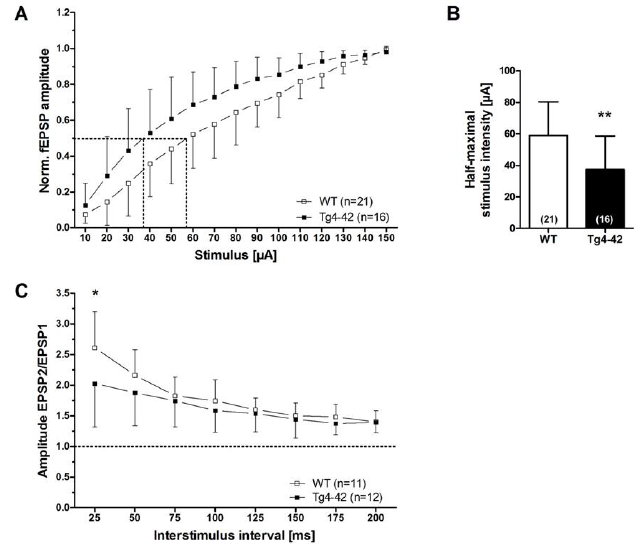
Figure 2. Aβ 4-42 induced neuronal hyperexcitability and affects short-term plasticity in 3-month-old Tg4-42 mice (taken from [16]). Impact of Aβ 4-42 on basal synaptic function and short-term plasticity in acute hippocampal tissue slices of Tg4-42 and controls at 3 months of age. ( A ) An altered basal excitatory synaptic transmission was demonstrated by a left shift of the input–output curve; ( B ) The half-maximal stimulus intensity (dashed lines in A) corroborated this observation; ( C ) Paired-pulse facilitation (PPF), quantified as a paradigm for synaptic short-term plasticity, was affected in Tg4-42 mice in comparison to wildtype control mice. ( A + C ) Mean ± SD. n = number of slices per group ( B ) Mean ± SD. The number of slices analyzed is indicated at the bottom of the bars. Half-maximal stimulus intensity: unpaired t -test, ** p < 0.01. Amplitude fEPSP2/fEPSP1: unpaired t -test, * p < 0.05.